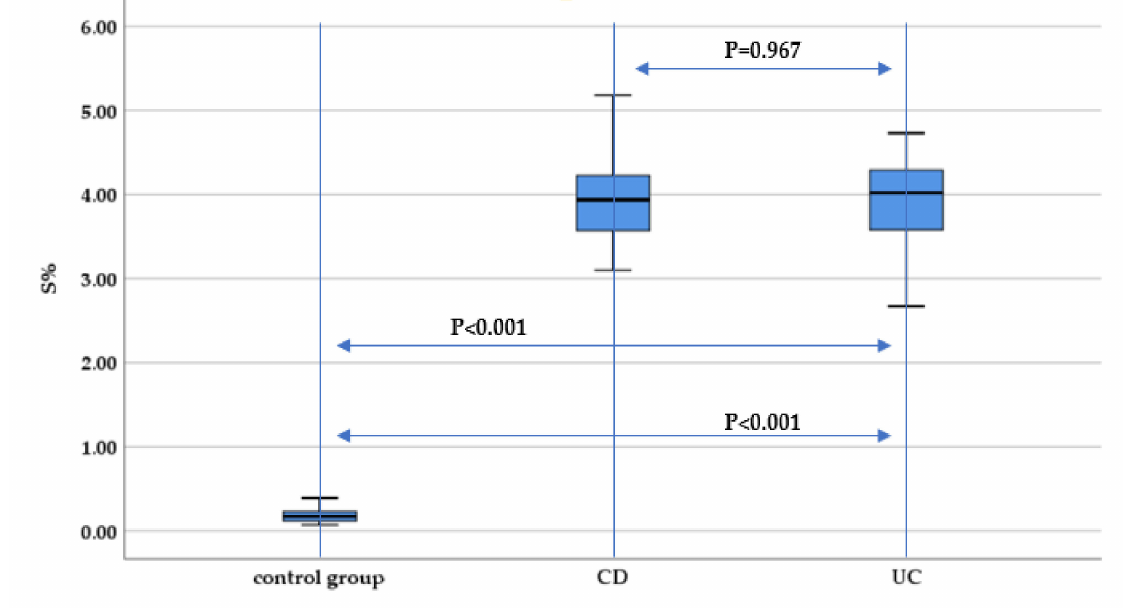
Figure 2. Evaluation of hair sulfur concentration (S%) between IBD subtypes (UC and CD) and the control group. Measurement of hair calcium concentration revealed statistically significant lower concentrations both for UC and CD patients compared to the control group ( p < 0.001). There were no significant differences for hair calcium concentration between UC and CD patients (Figure